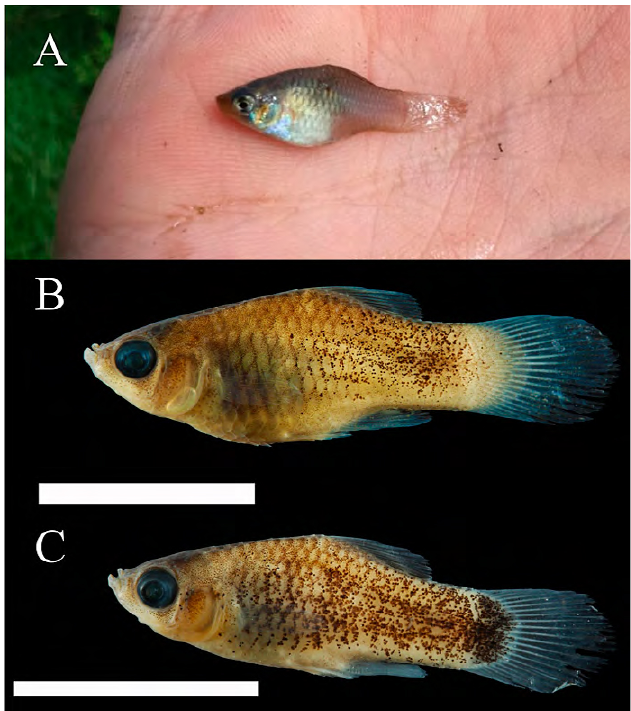
Figure 3. Xiphophorus maculatus. A: Live specimen, female. B: